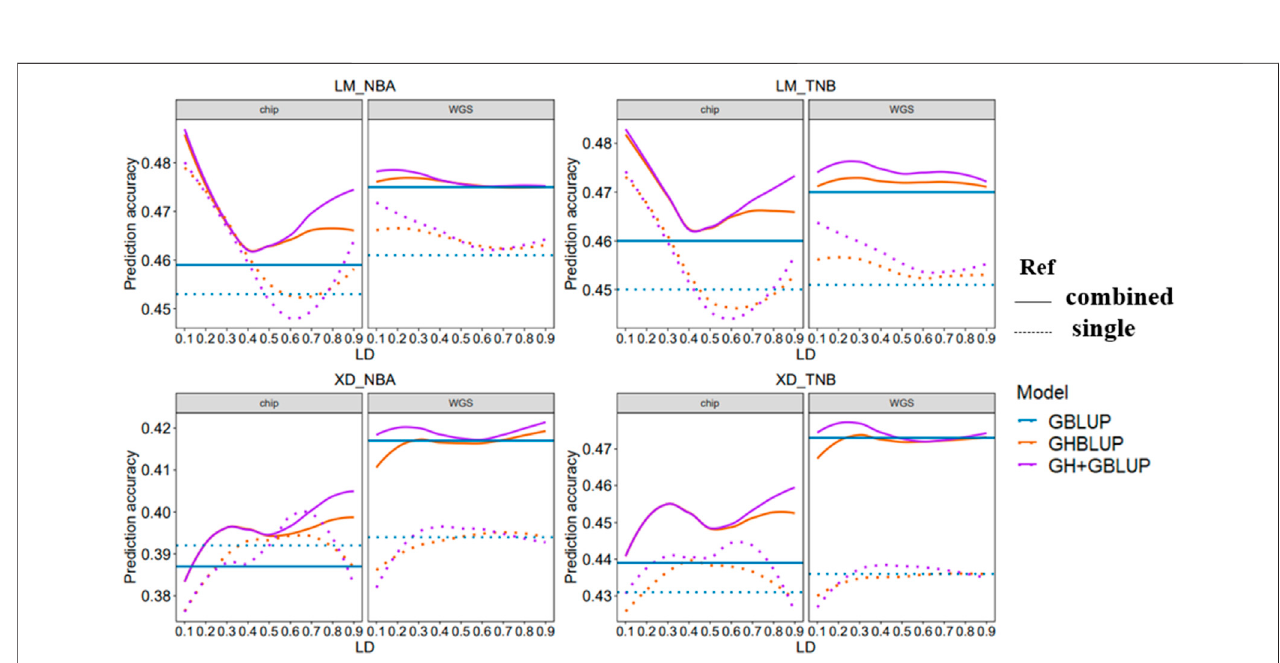
FIGURE 3 | Genomic prediction accuracy of all scenarios with different r 2 thresholds. The left side shows the trend of accuracy predicted using the 80 K chip data while the right side using the WGS data. The different colored lines represent different prediction methods in which blue, orange, and purple line represent GBLUP, GHBLUP, and GH + GBLUP, respectively. The solid line represents the prediction accuracy trend of combined population, while the dotted line represents the single population.